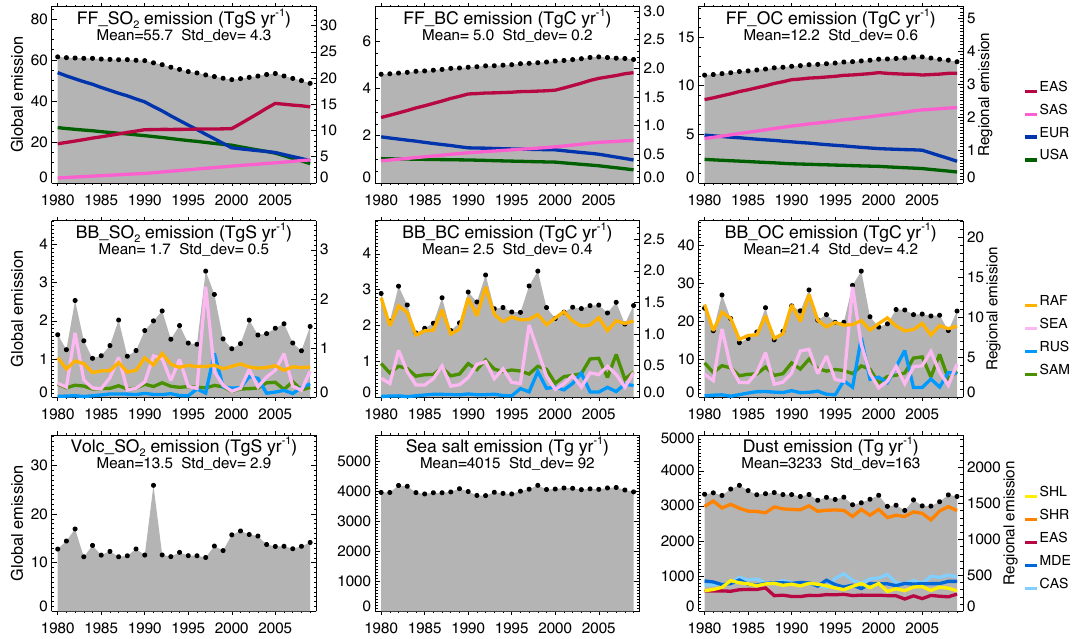
Fig. 2. Emissions from fossil fuel/biofuel (FF) (top row) and biomass burning (BB) (middle row) sources shown as global total (black circles on top of the grey shaded area, left y axis scale) and from major source regions (colored lines, right y axis scale) of SO 2 (left), BC (middle), and OC (right). Bottom row showing total volcanic SO 2 (left), sea salt (middle), and total and regional dust emissions (right, regional emission in colored lines with scale on right y axis). Region domains in Fig. 1 and names in Table 1. The 30-year mean values and standard deviation of the total annual emission are listed on each